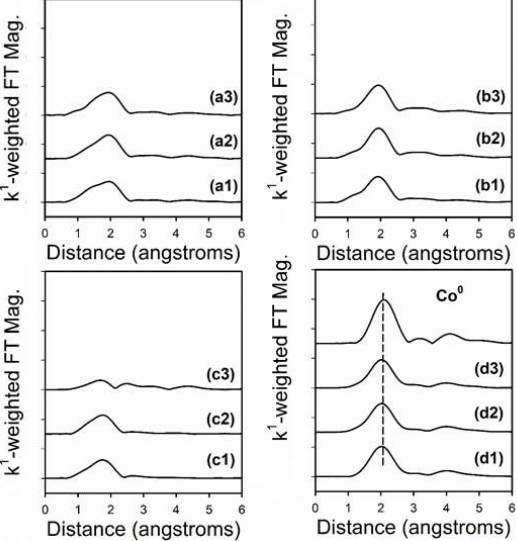
Figure 16. EXAFS snapshots of ( bottom right ) reference Co 0 obtained from TPR-XANES trajectory of the calcined 25% Co/Al 2 O 3 catalyst. EXAFS snapshot spectra for samples prepared from cobalt chloride along the TPR trajectory, including (1) the calcined catalyst, (2) the uncalcined catalyst, and (3) the uncalcined catalyst with 0.5% Pt promoter at ( a ) the point of maximum cobalt chloride, ( b ) the point of partial cobalt chloride decomposition #1, ( c ) the point of partial cobalt chloride decomposition #2, and ( d ) the point of maximum Co 0 content following TPR. Dashed line: 1st shell Co-Co coordination in Co 0